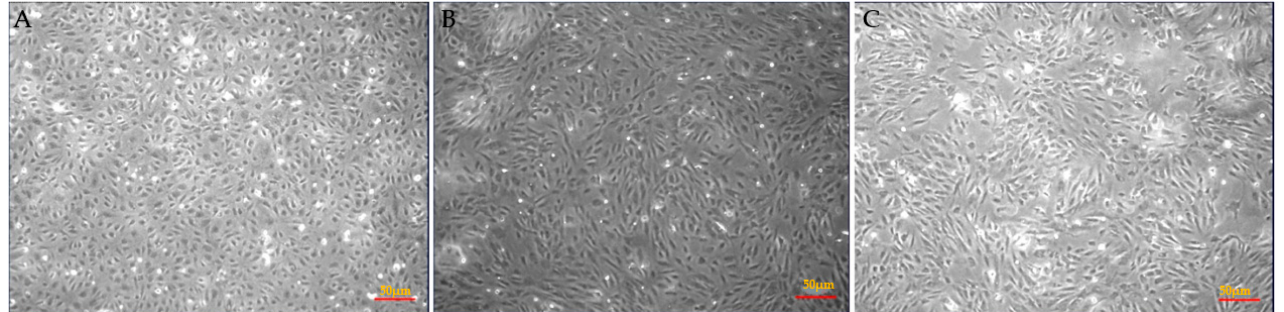
Figure 1. SAA-stimulates morphological changes in cultured HAEC. Representative images are shown for confluent HAEC treated with ( A ) DMSO (vehicle control) ( B ) 10 µg/mL SAA for 24 h, or ( C ) pre-treated with 25 µM 4-MetT for 24 h prior to addition of 10 µg/mL SAA and incubated further for 24 h. Data shown are representative of a single field of view, ( A – C ). Images were captured using an inverted light microscope with 10× magnification. Insets to panels ( A – C ) show higher magnification images of cells across the corresponding treatment groups.